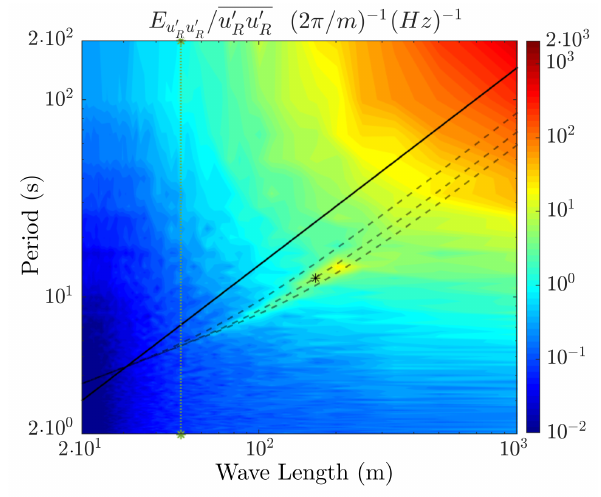
Figure 11. One quadrant ( Q ++ ) of the wave-number–angular-frequency 2D turbulent spectrum ( k , w ) for Case 02c. The lines denote the characteristic scales described in Figure E u (cid:48) (cid:48) R u R